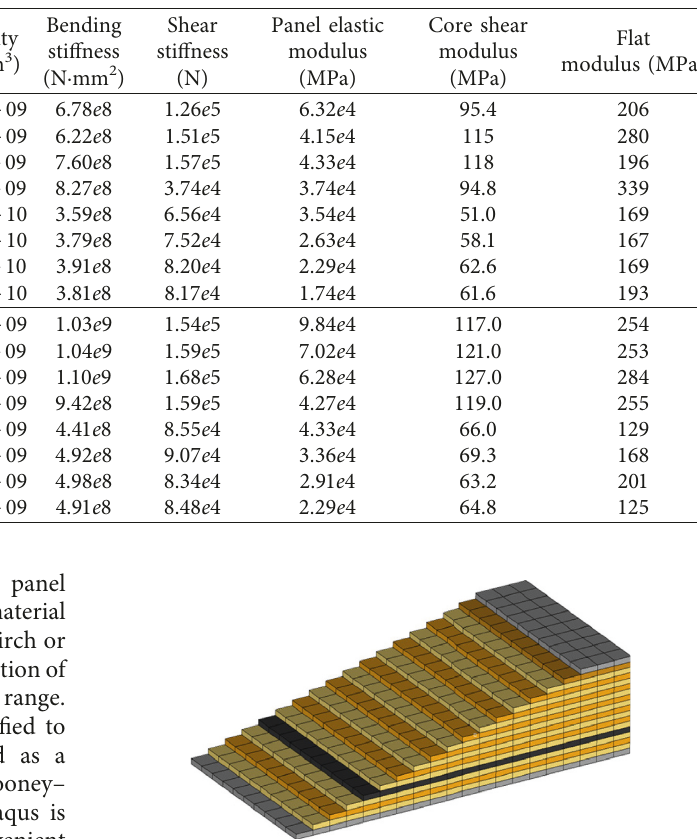
Table 1: Test and calculation results of mechanical properties of composite multilayer panels.